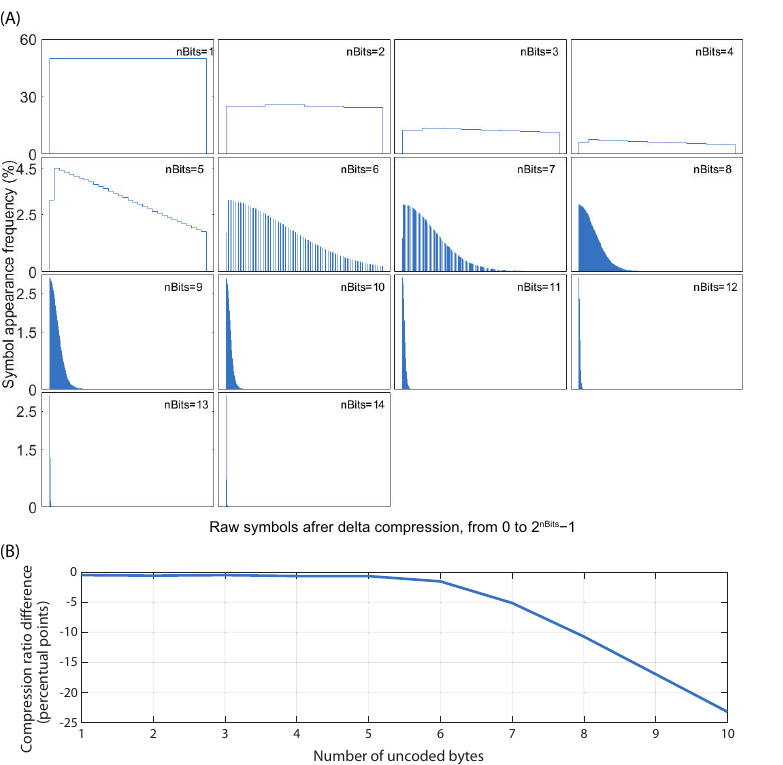
Figure 5. ( A ) Symbol distribution of a delta-coded sample signal, in absolute value, for a different amount of masked bits. The lower nBits are kept and the others discarded before plotting the proba- bility distributions. The X-axis of each plot are the different symbols, from 0 to 2 nBits . ( B ) Degradation, in percentual points, of the compression efficiency when the different amount of bits are transmitted without being coded by the Huffman